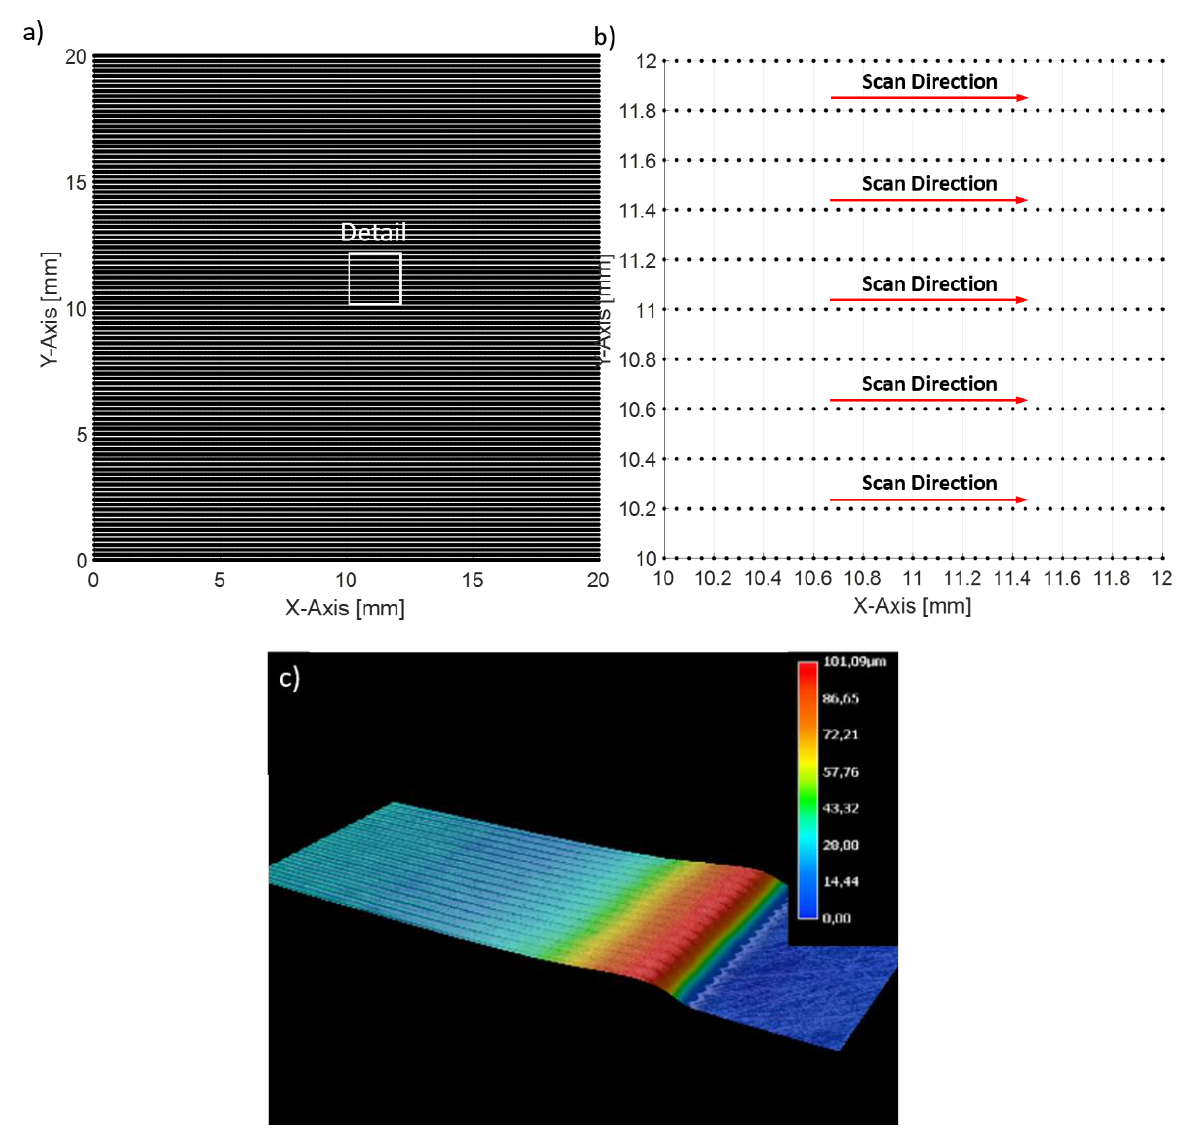
Figure 2. ( a ) Electron beam scan strategy followed to produce the micro-grooves (G) over 20 mm × 20 mm area. ( b ) detail view of ( a ). ( c ) 3D reconstruction of beam figure.